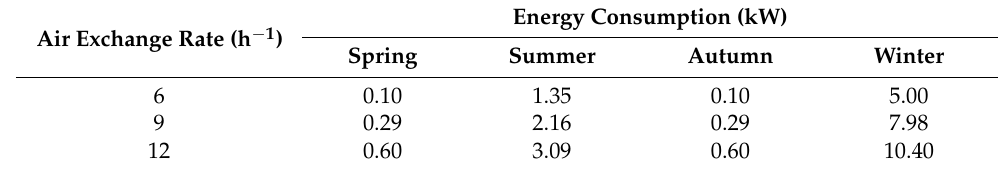
Table 3. Energy consumption of ventilation filter system with different air changes in different seasons.